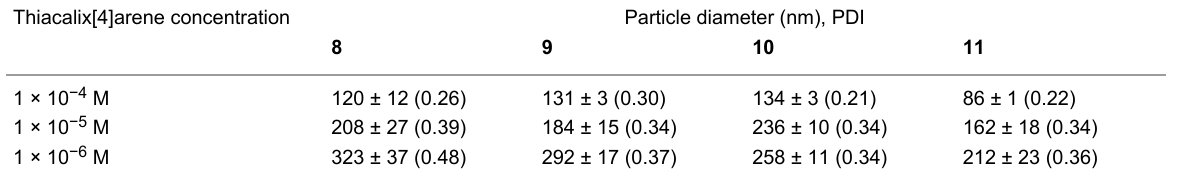
Table 1: Diameter and polydispersity index (PDI) of macrocycles 8 – 11 at different concentrations in water. Thiacalix[4]arene concentration